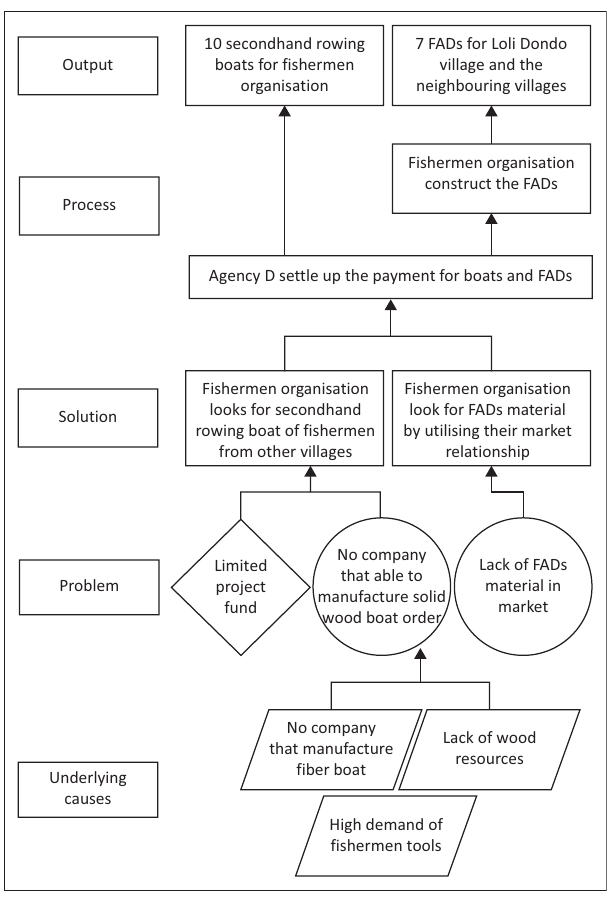
FIG URE 5: Community reflection on the comparison of agency-driven and community-driven approaches.